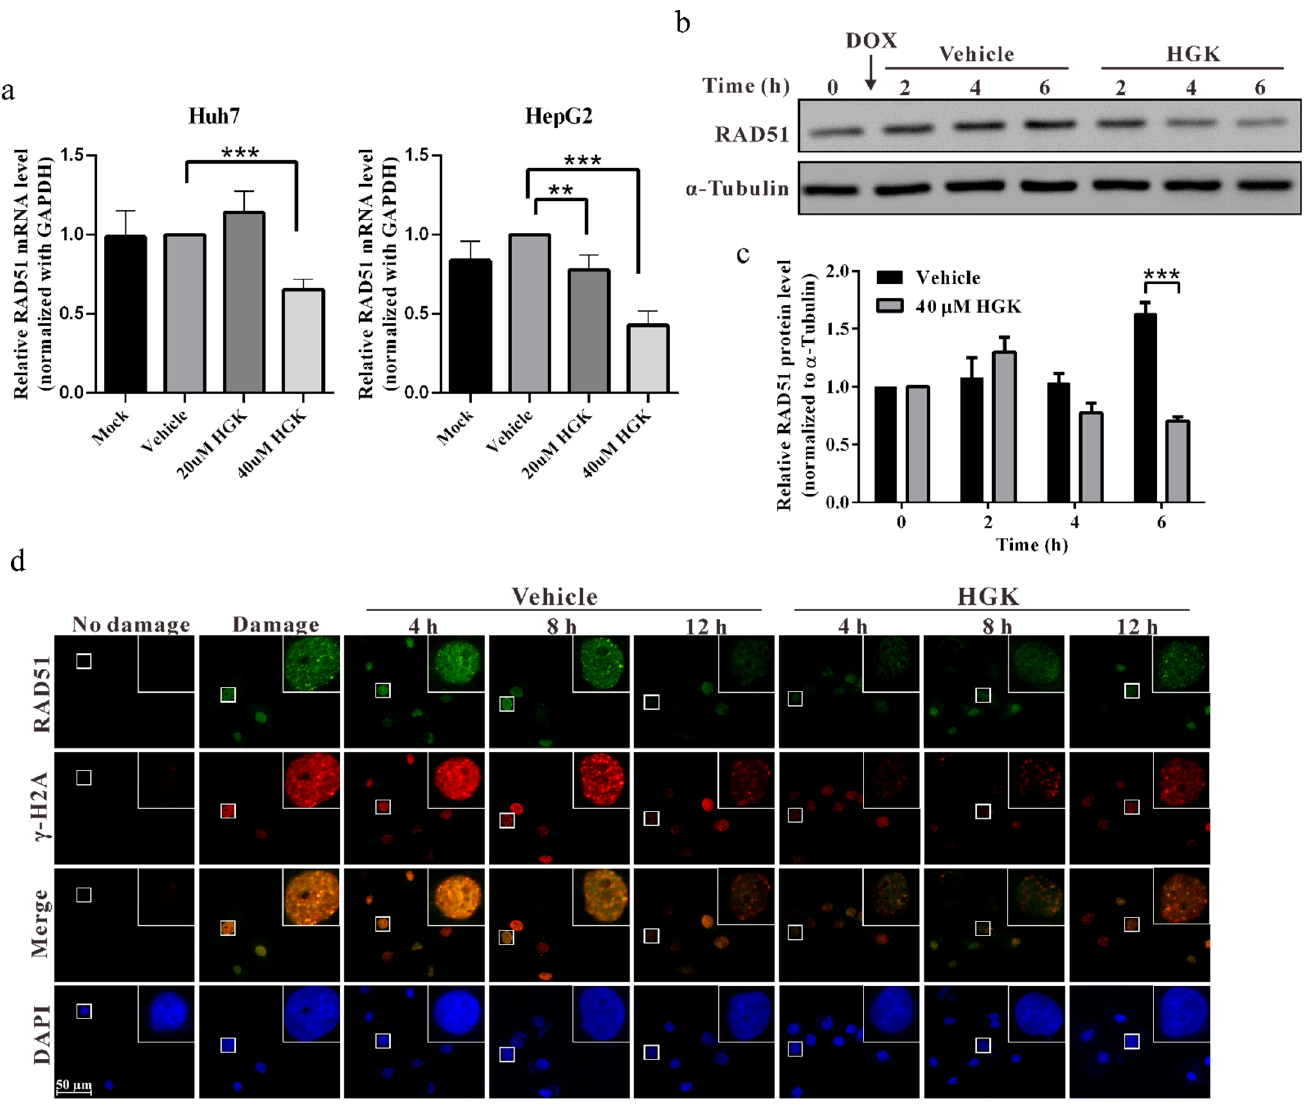
Figure 4. Hydroxygenkwanin (HGK) inhibits HR by suppressing the expression of RAD51. Huh7 and HepG2 cells were treated with different concentrations of HGK or vehicle control for 48 h, and the cells were harvested and subjected to ( a ) quantitative reverse transcription-polymerase chain reaction and ( b ) Western blotting analysis to detect the expression of RAD51. Glyceraldehyde 3-phosphate dehydrogenase and α -tubulin served as internal controls. ( c ) Quantitative results of the Western blotting analysis. Mock: cells treated with DMEM medium. Vehicle: cells treated with DMSO. p < 0.01 (**), p < 0.001 (***). All data were expressed as mean ± standard deviation values obtained from three independent experiments. ( d ) Huh7 cells were treated with 0.5 μ M doxorubicin for 1 h to induce DNA damage, followed by recovery in a medium with or without 40 μ M HGK. Cells were processed for immunofluorescence staining at various time points to detect the formation of RAD51 (green) and γ H2AX (red) foci. Nuclei were stained with 4 ′ ,6-diamidino-2-phenylindole (blue).